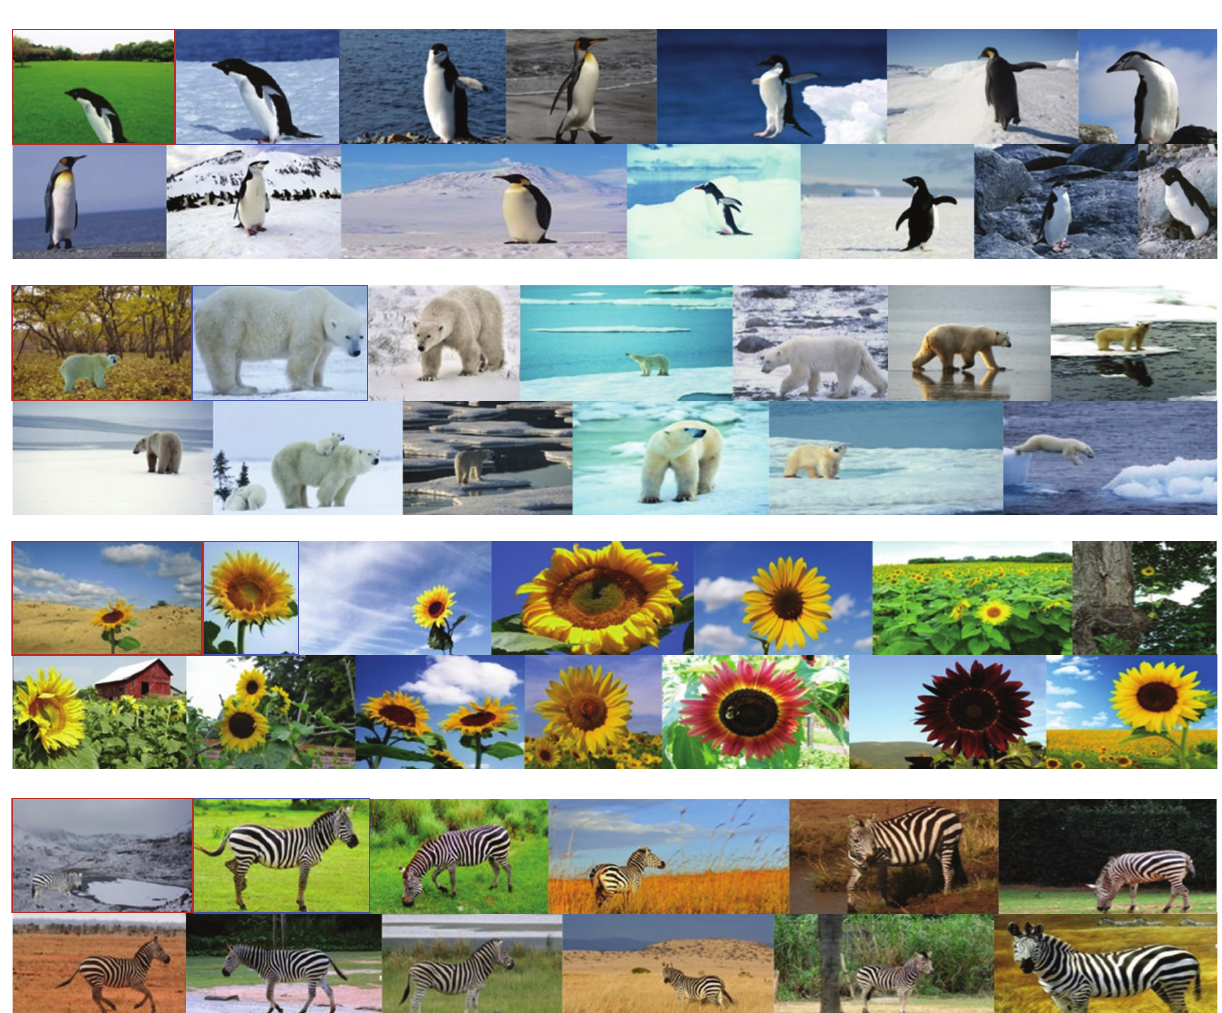
Figure 8: Results of scene consistency